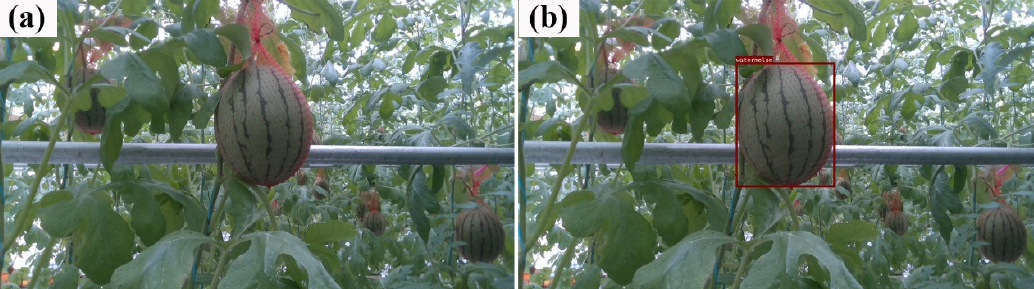
Figure 12. RealSense camera image example: ( a ) the RGB image; ( b ) the RGB image overlaid with one class ground truth.